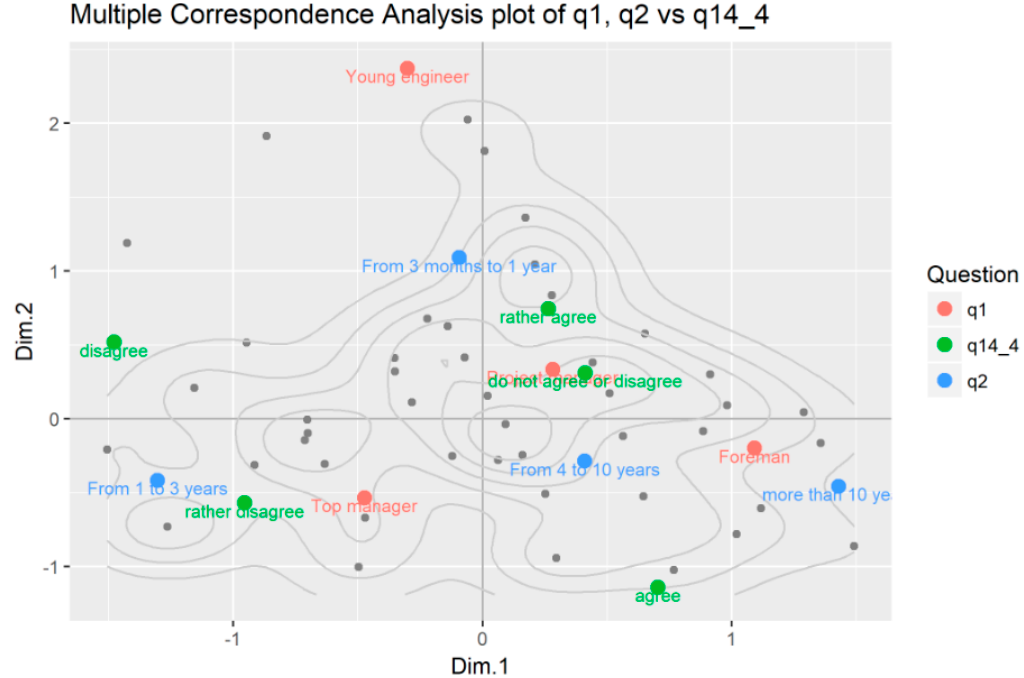
Figure 5. Answers to the question: there is a shortage of skilled employees in the company.